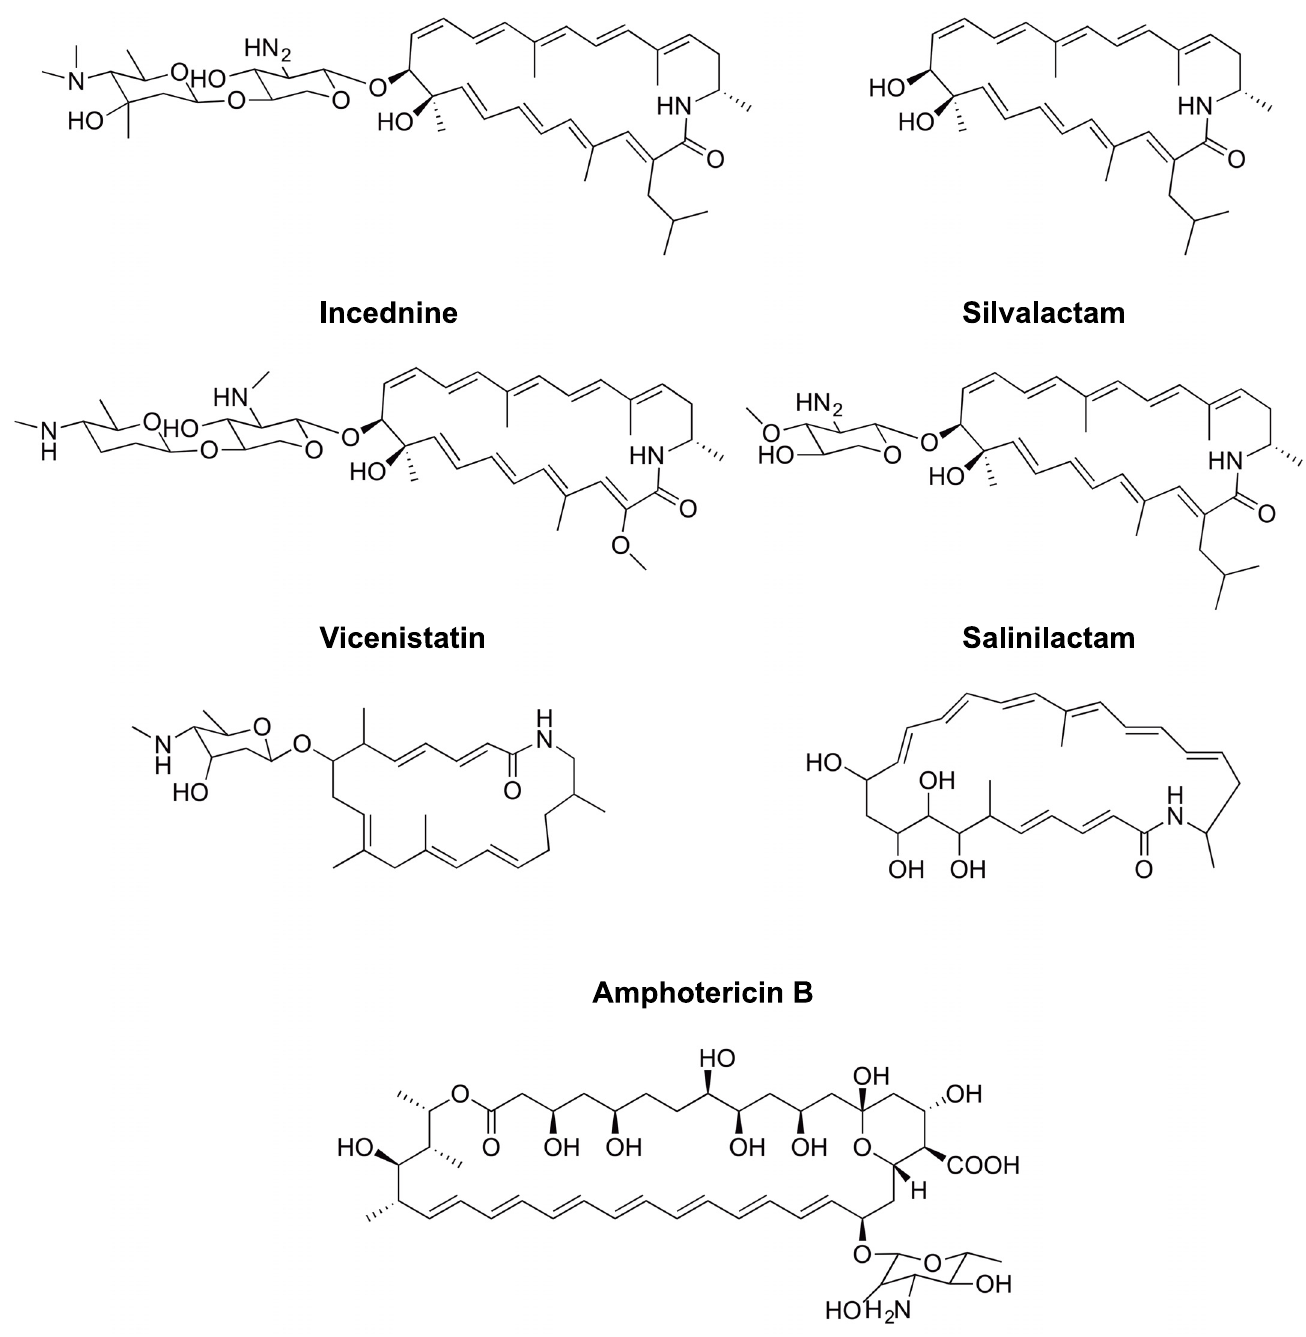
Fig 1. Polyene antibiotics. Chemical structures of auroramycin, auroramycin aglycon, vicenistatin, incednine, silvalactam, salinilactam, and amphotericin B.